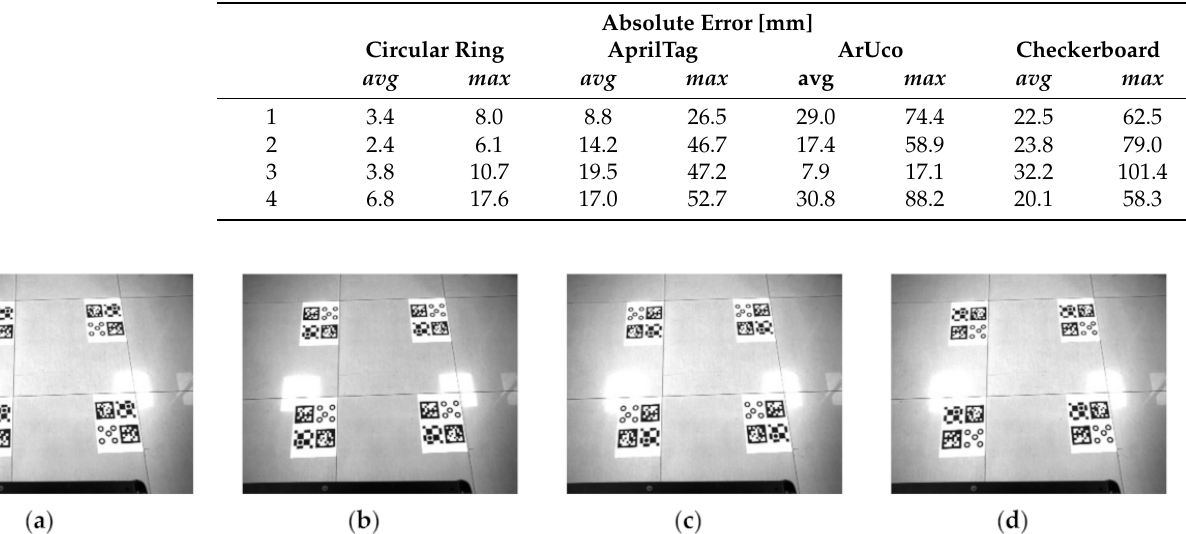
Table 8. Comparison of positioning accuracy under position transformation.